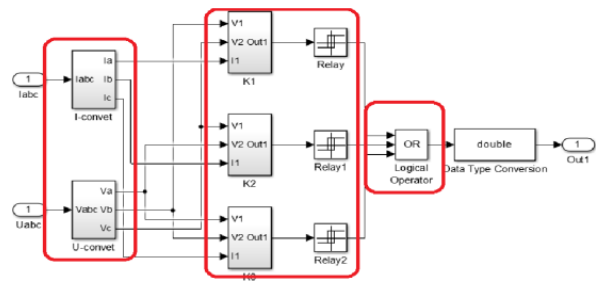
Figure 5: Power directional element model